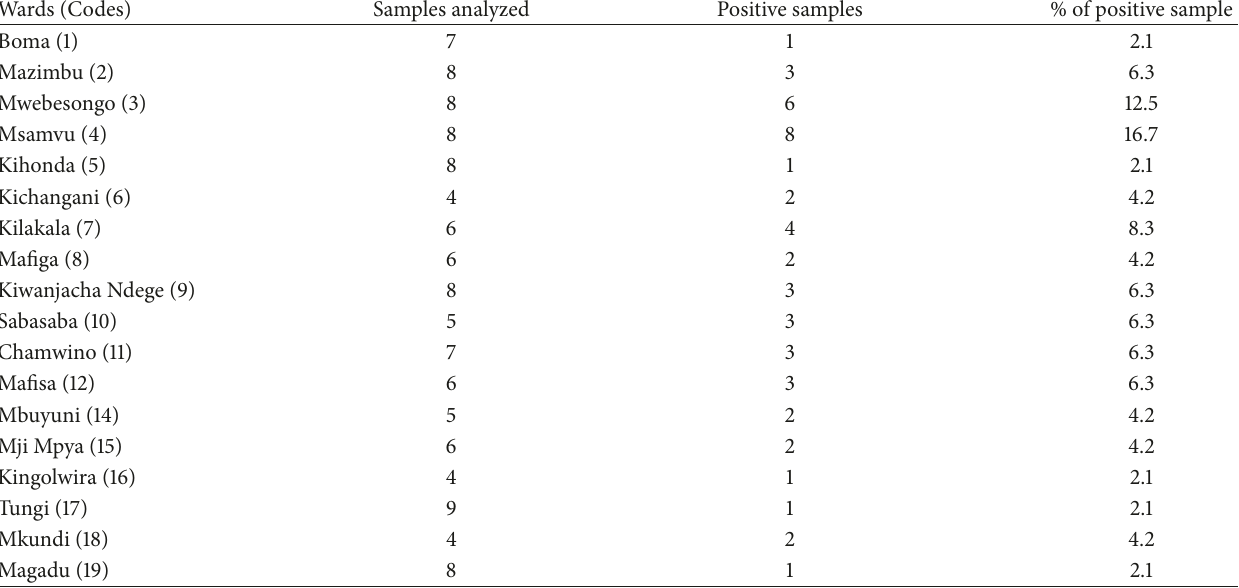
Table 2: The S. aureus isolated from milk in the Morogoro Municipality.